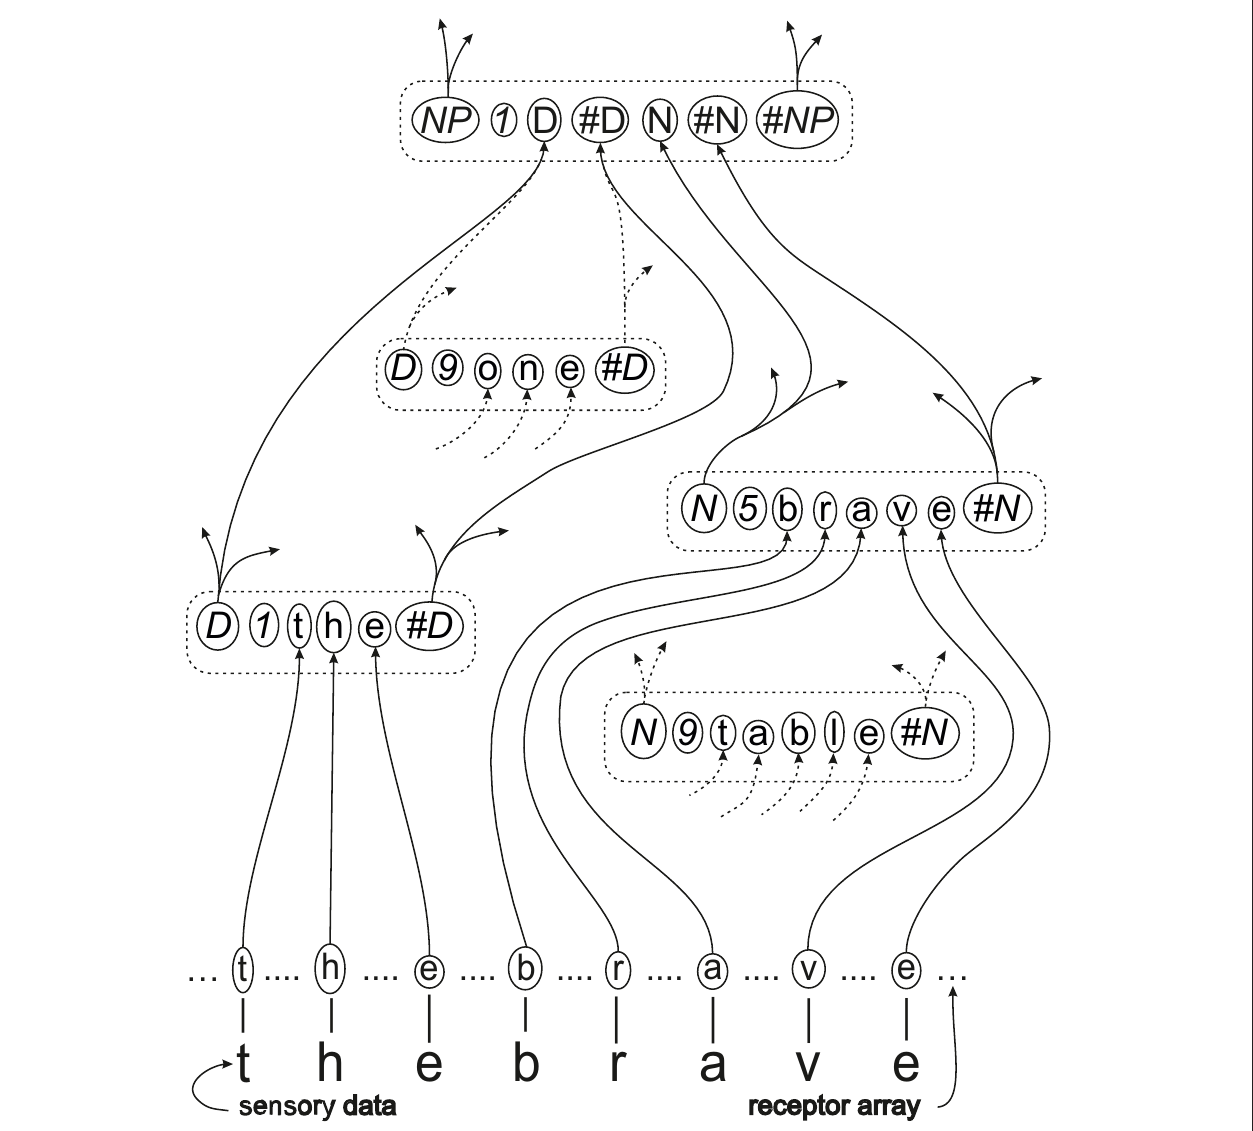
FIGURE 3 | A schematic outline of how part of the multiple alignment shown in Figure 2, with associated patterns and symbols, may be expressed in SP-neural as neurons and their inter-connections. The meanings of the conventions in the figure, and some complexities that are not shown in the figure, are explained in this main section and ones that